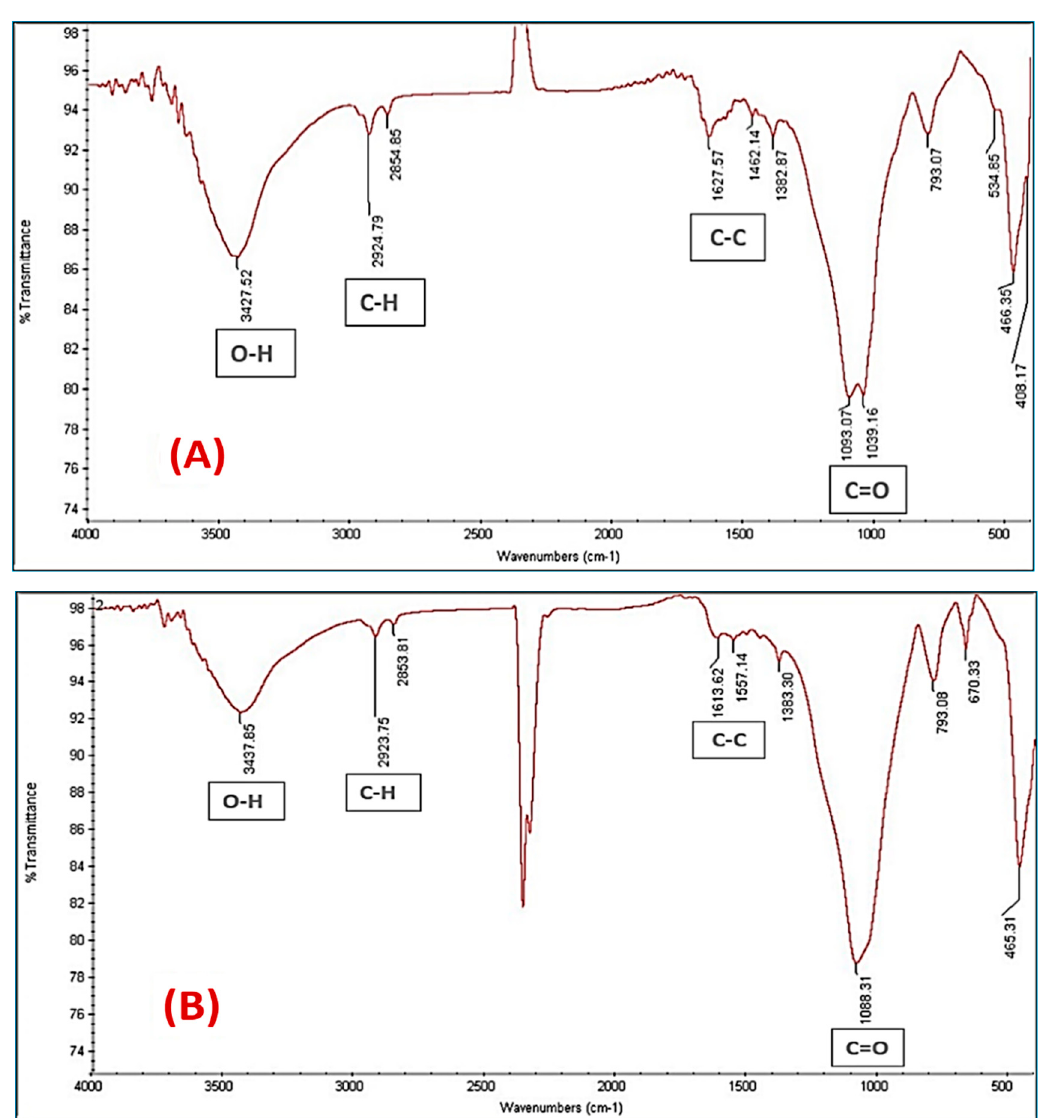
Figure 4. FTIR spectrum of AC(C-3): ( A ) AC(C-3) before adsorption, ( B ) AC(C-3) after adsorption Fe(III) and Mn(II).